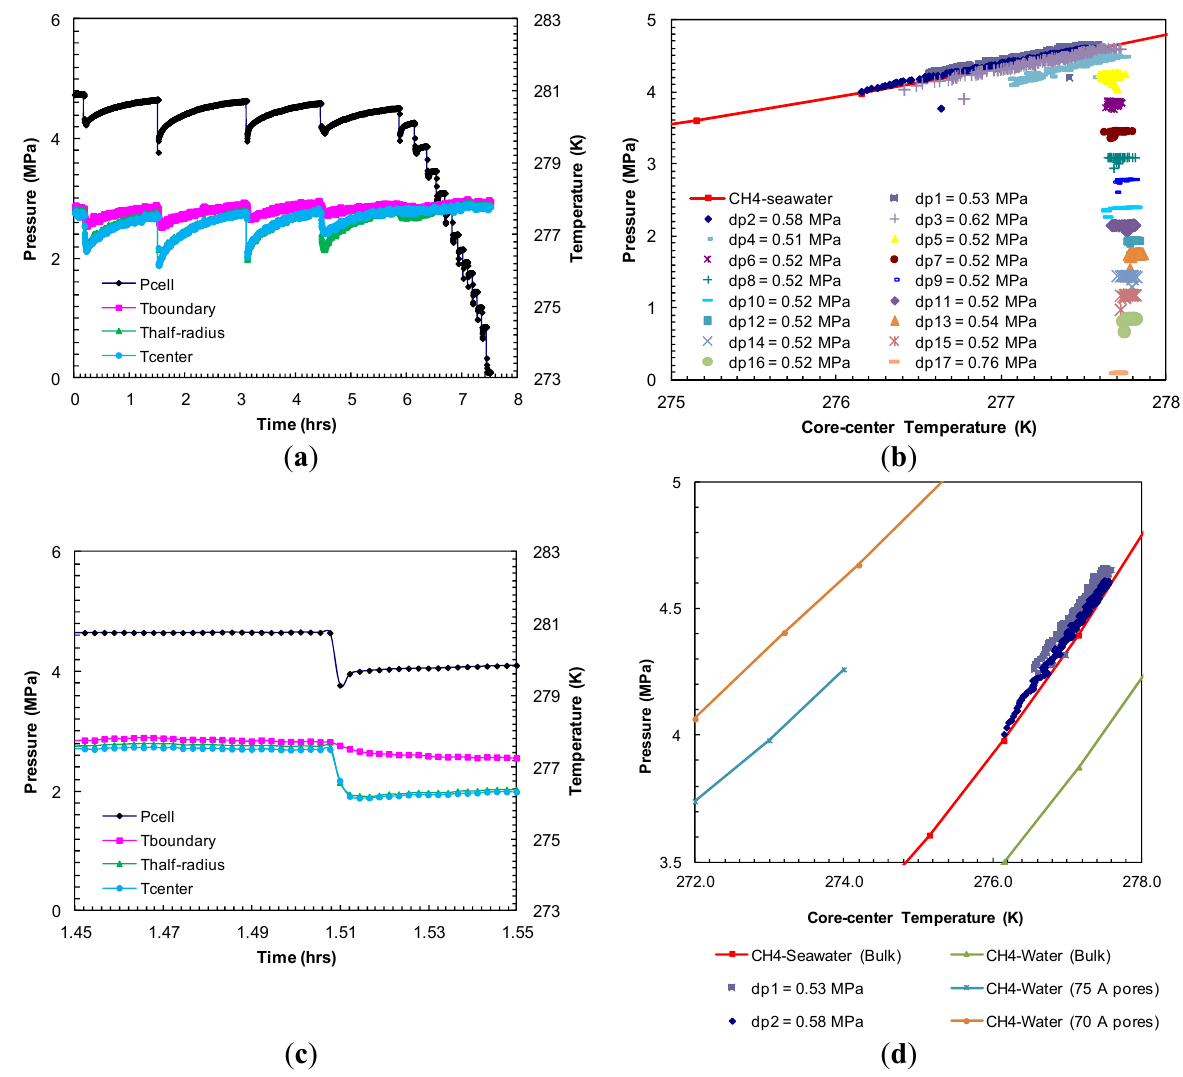
Figure 3. ( a ) Cell pressure/temperatures against time during dissociation with sequences of pressure drop and thermally induced dissociation in Experiment 1; ( b ) Post-depressurization equilibrium pressure against temperature measured at the center of the sand-pack in Experiment 1. Each dataset corresponds to pressure-temperature ( P - T ) conditions during thermally induced dissociations. Equilibrium conditions of methane hydrates-seawater were obtained from Duan and Sun [18]; ( c ) Cell pressure/temperatures against time during dissociation at 1.51 h from ( a ); ( d ) Post-depressurization (dps1–5) equilibrium pressure against temperature measured at the center of the sand-pack from ( b